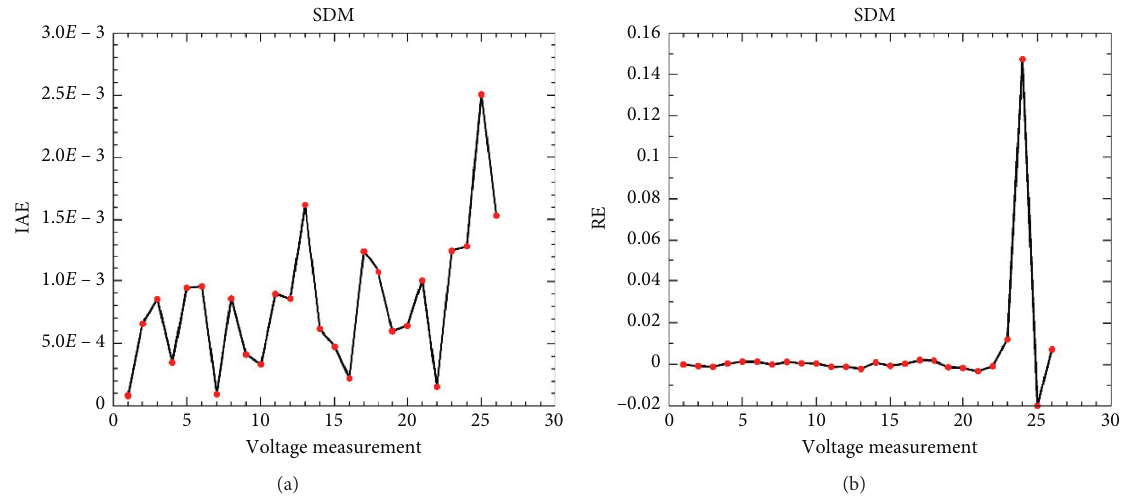
Figure 6: IAE (a) and RE (b) between the simulated data by SDM and the experimental data.